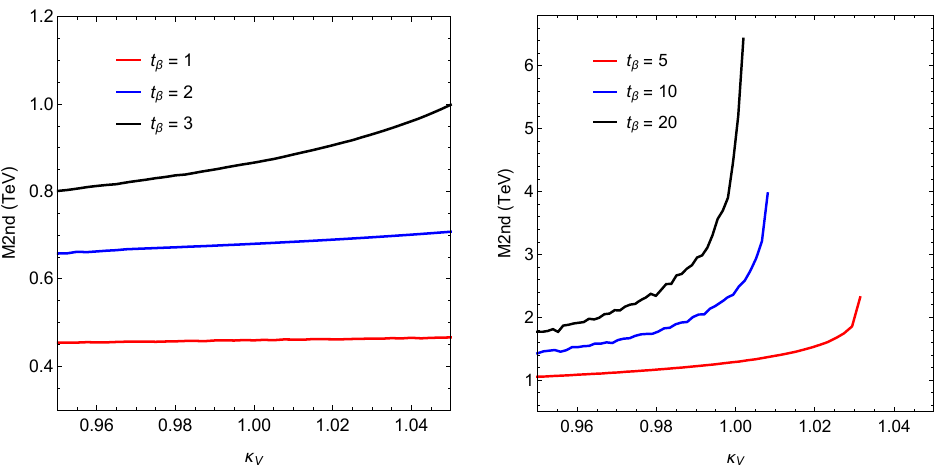
) obtained by imposing Bound A as a , m H , m H H 5 3 1